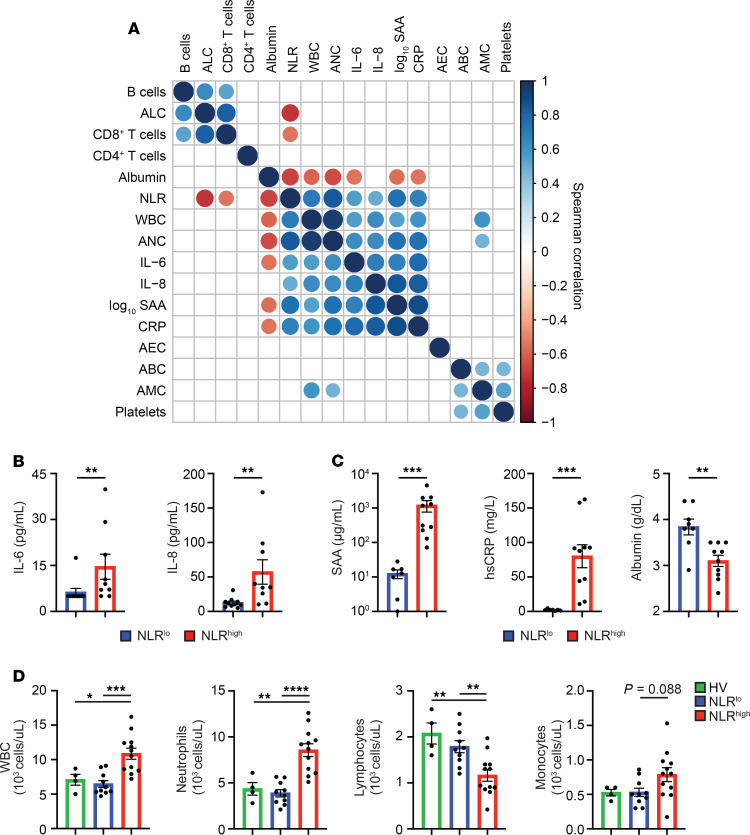
An inflammatory network is present in the blood of patients with PDA.(A) Correlation matrix displaying Spearman’s correlations among clinical blood counts, cytokines, and acute phase reactants of n = 22 patients. Correlations are shown when P < 0.05. Positive correlations are shown in blue and negative correlations are in red. (B) Quantification of inflammatory cytokines in patient plasma among NLRlo (NLR < 3.1) and NLRhi (NLR > 3.1) patients. (C) Quantification of acute phase reactants in patient plasma. (D) Quantification of clinical blood counts. Each dot represents an individual HV (green) or NLRlo (blue) or NLRhi patient (red). Mann-Whitney U tests (B and C) and 1-way ANOVA with Tukey’s multiple comparisons tests (D) were performed. *P < 0.05; **P < 0.01; ***P < 0.001, ****P < 0.0001. HV, healthy volunteer; SAA, serum amyloid A; hs, high-sensitivity; WBC, white blood cell count; ANC, absolute neutrophil count; NLR, neutrophil-lymphocyte ratio; ABC, absolute basophil count; AMC, absolute monocyte count; AEC, absolute eosinophil count; ALC, absolute lymphocyte count.